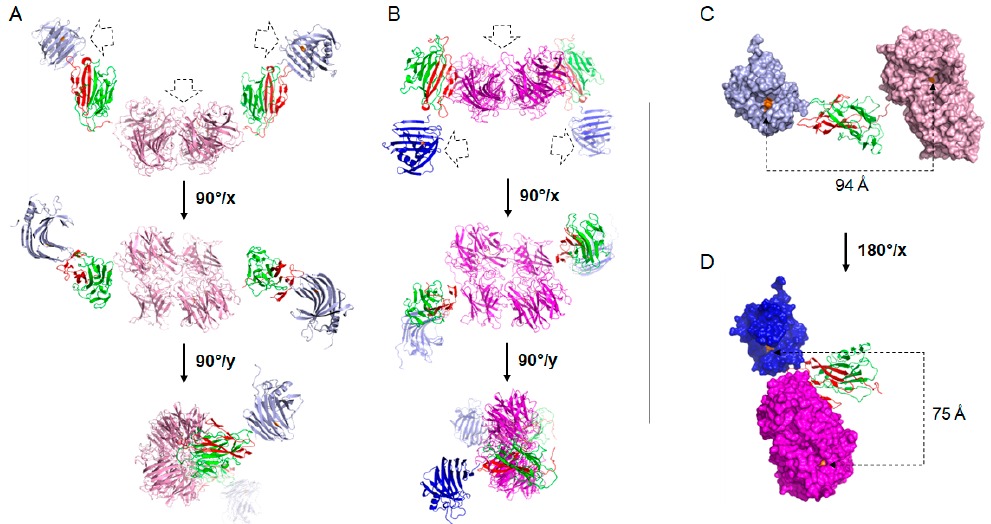
Figure 4. SAXS data compatible models of dimer of ( A ) His -In- Np Xyn11A-Jo- Bh Xyl43 arc shaped and ( B ) His -In- Np Xyn11A- Bh Xyl43-Jo “M” shaped. Structures are shown in three orientations. Arrow in drawn lines indicates access to catalytic pockets. ( C ) Details of monomeric organisation within the His -In- Np Xyn11A-Jo- Bh Xyl43 complex and ( D ) His -In- Np Xyn11A- Bh Xyl43-Jo complex. Drawn line indicates the distance separating the catalytic pocket of individual enzyme. Domain Np Xyn11A is in blue (light for His -In- Np Xyn11A-Jo- Bh Xyl43, dark for His -In- Np Xyn11A- Bh Xyl43-Jo), domain Bh Xyl43 is in magenta (light for His -In- Np Xyn11A-Jo- Bh Xyl43, dark for His -In- Np Xyn11A- Bh Xyl43-Jo), domain In is in green and domain Jo is in red. Catalytic residues are in orange.